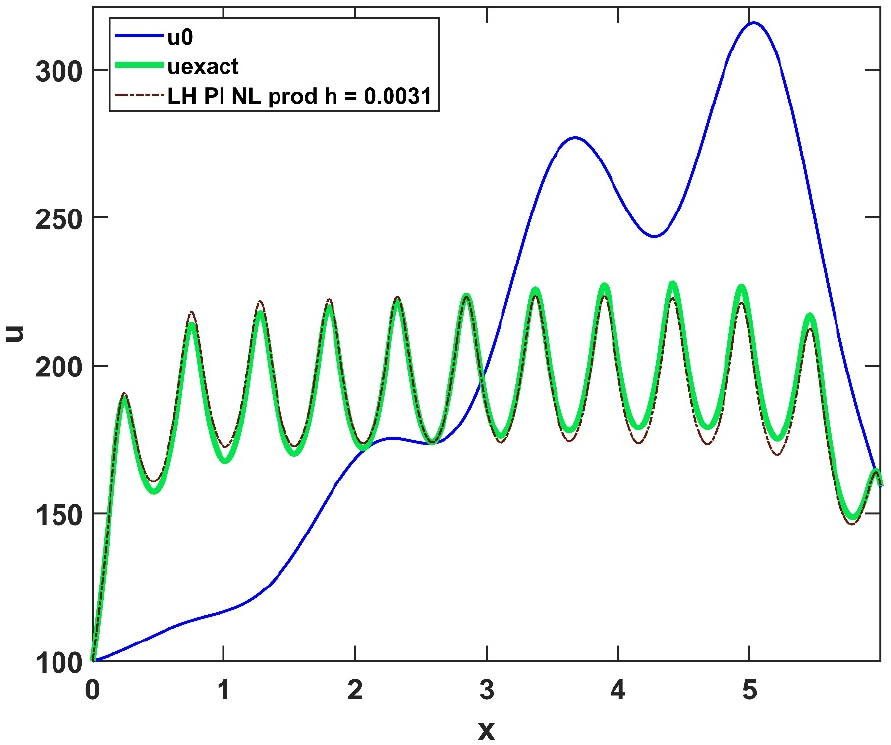
Figure 8. The temperature u vs. the x variable in the case of the initial function u 0 , the reference solution at t fin , and the nonlocal version of the LH method for h = 2 · 10 − 3 .